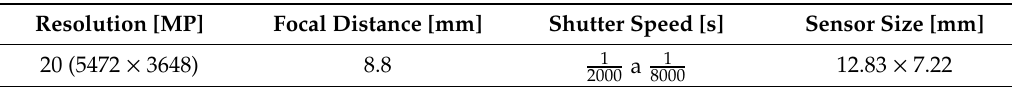
Table 2. UAV Phantom 4 Pro flight features.